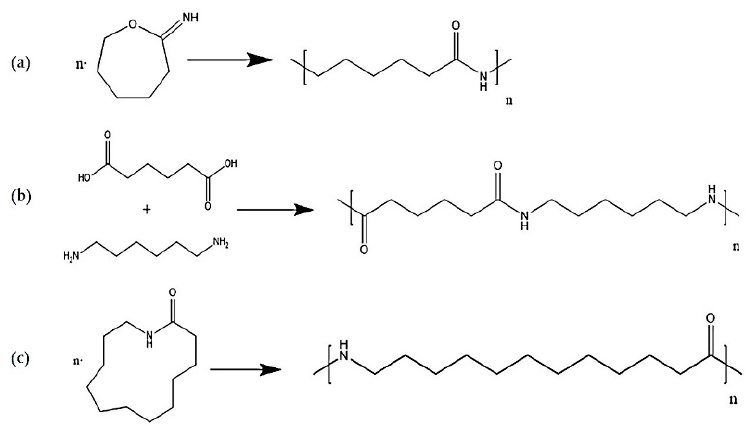
Figure 1. Reaction equations for the polymerization of polyamide 6 ( a ), polyamide 6.6 ( b ), and polyamide 12 ( c ).